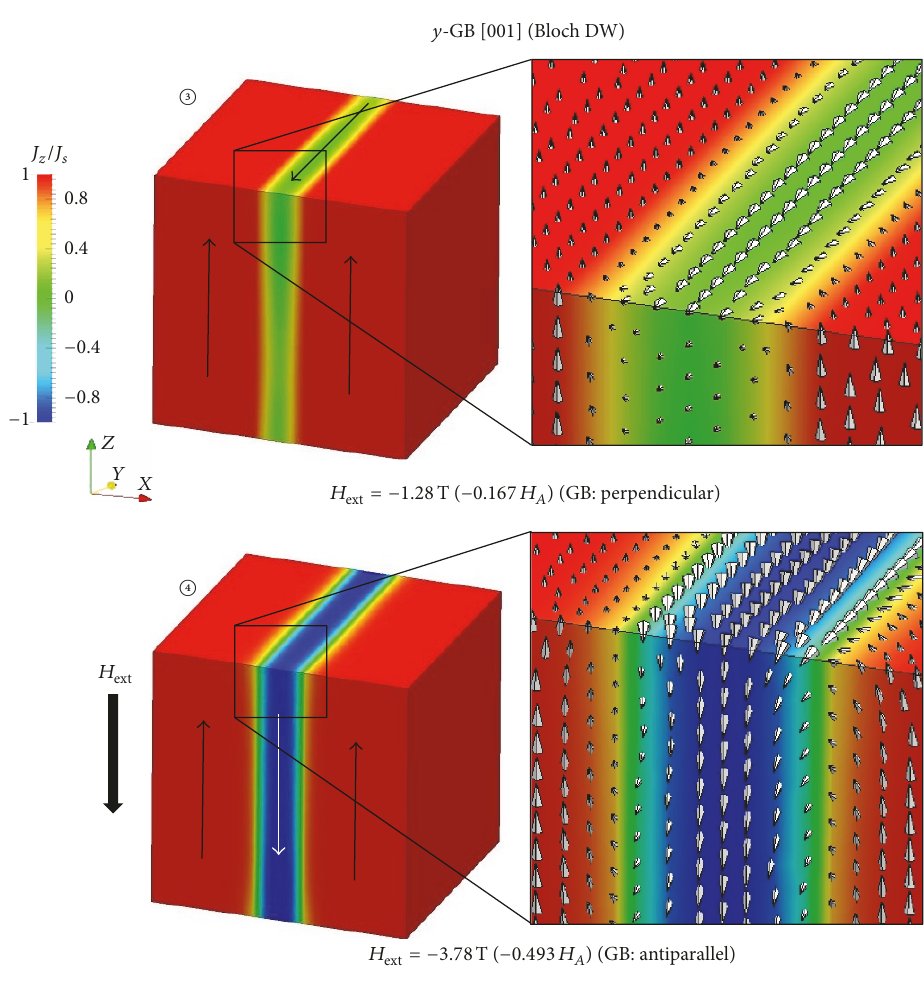
Figure 18: Magnetization states of the 𝑦 -GB [001] : C the magnetization of the GB is perpendicular to 𝐻 ext and the adjacent grains and D the magnetization of the GB is parallel to the external field and antiparallel to the adjacent grains forming a Bloch DW.